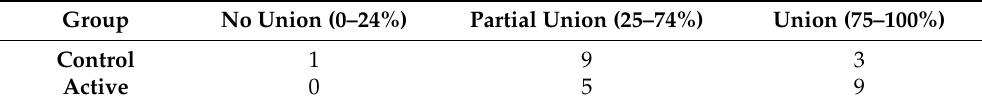
Table 2. Fractures categorization by extent of the union at 4 weeks.